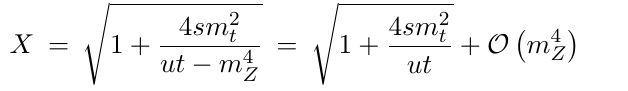
Figure 3 . LO partonic di(cid:11)erential cross section for gg dotted lines correspond to the exact, high-energy and large- m t